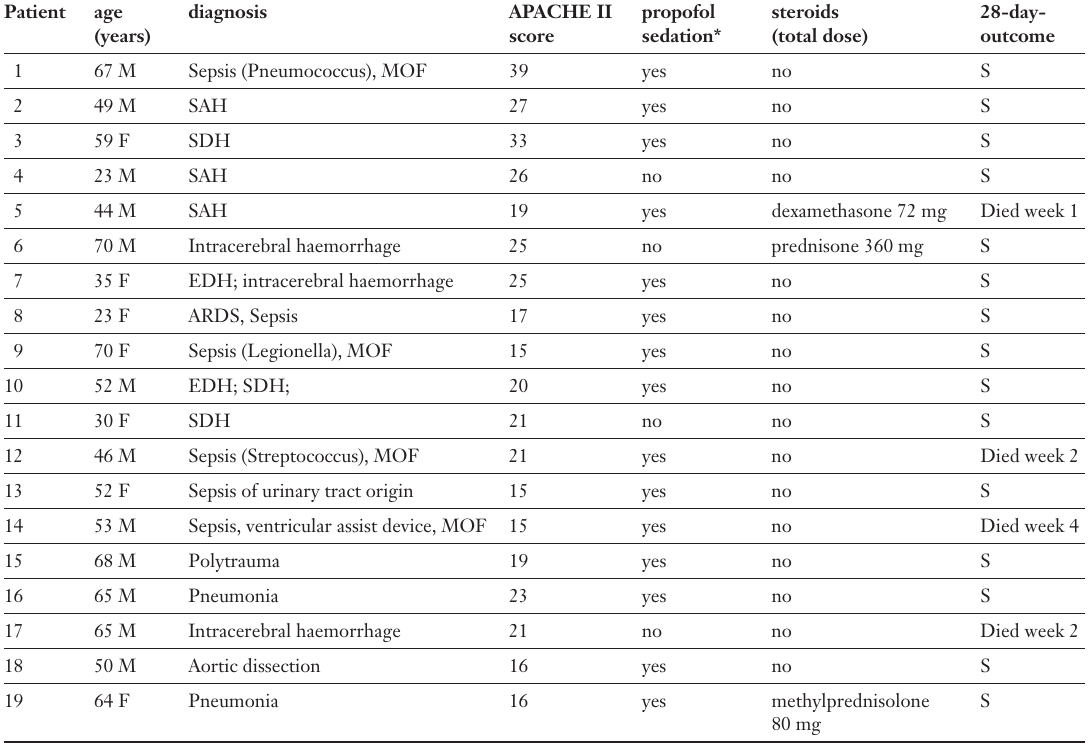
Table 1 Patient clinical